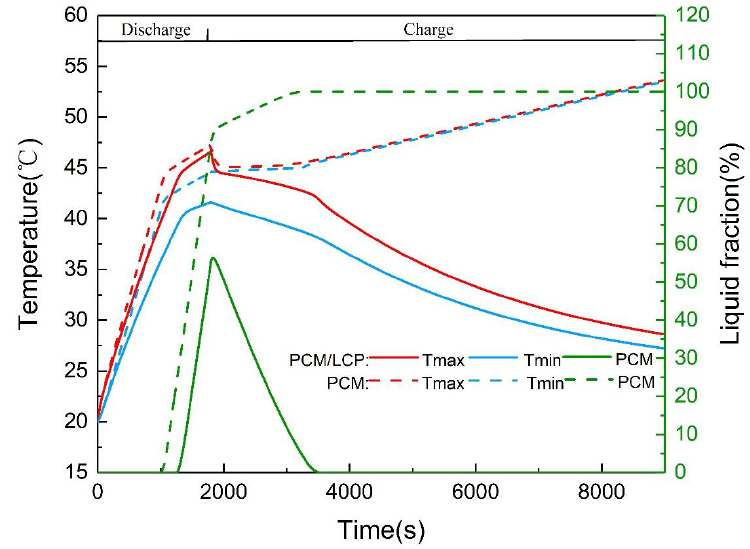
Figure 11. T max and T min curves and PCM liquid fraction curve with PCM module and PCM/liquid cooling plate under 1 cycle.